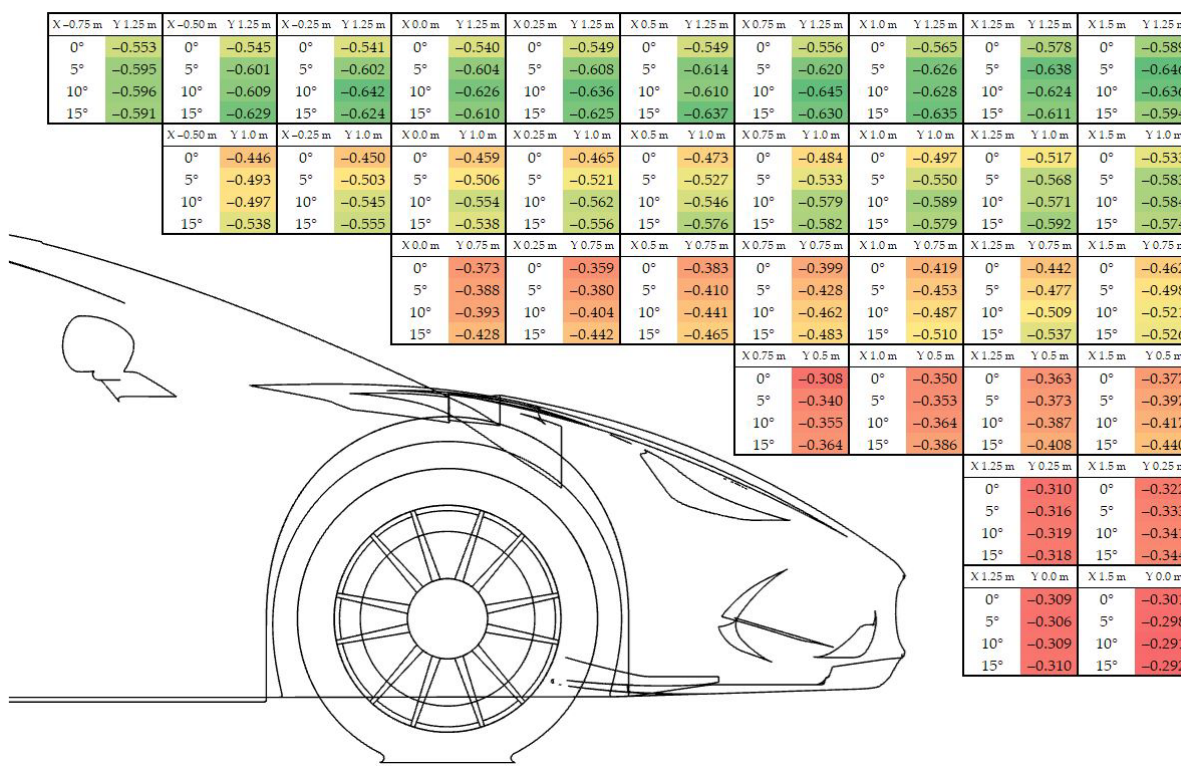
14 of 32 Figure 17. Visualization of the analyzed positions of the front wing.